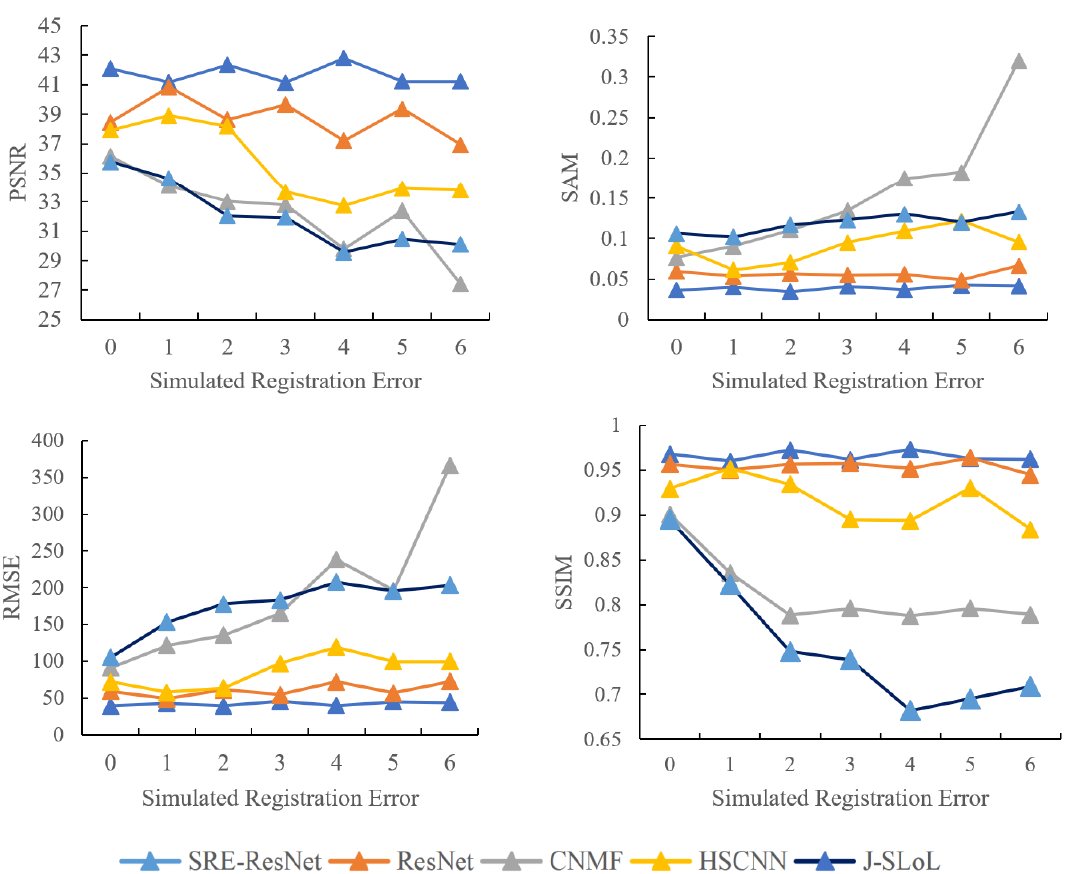
Figure 12. Quality assessment result of Dataset II with different simulated registration error.